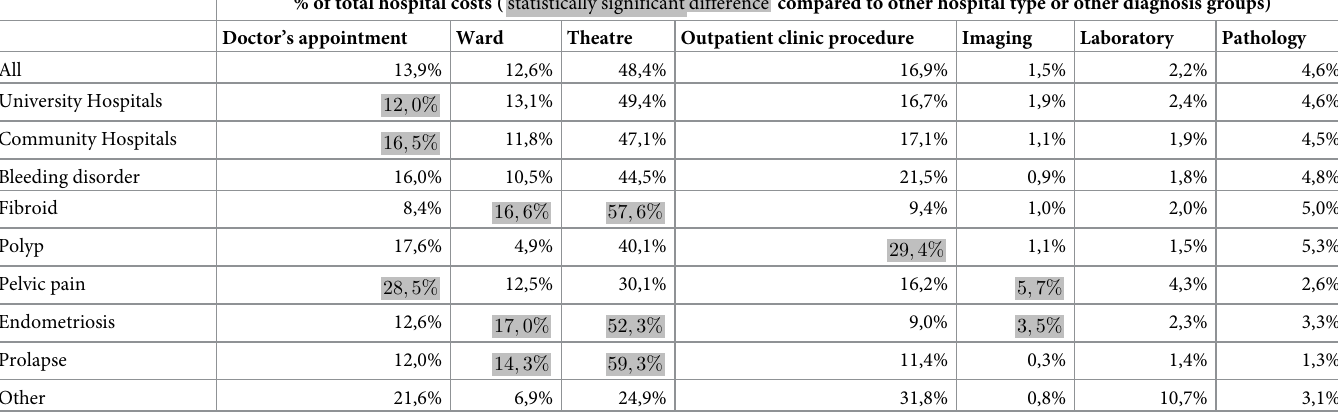
Table 1. Direct hospital cost distribution according to hospital and diagnosis